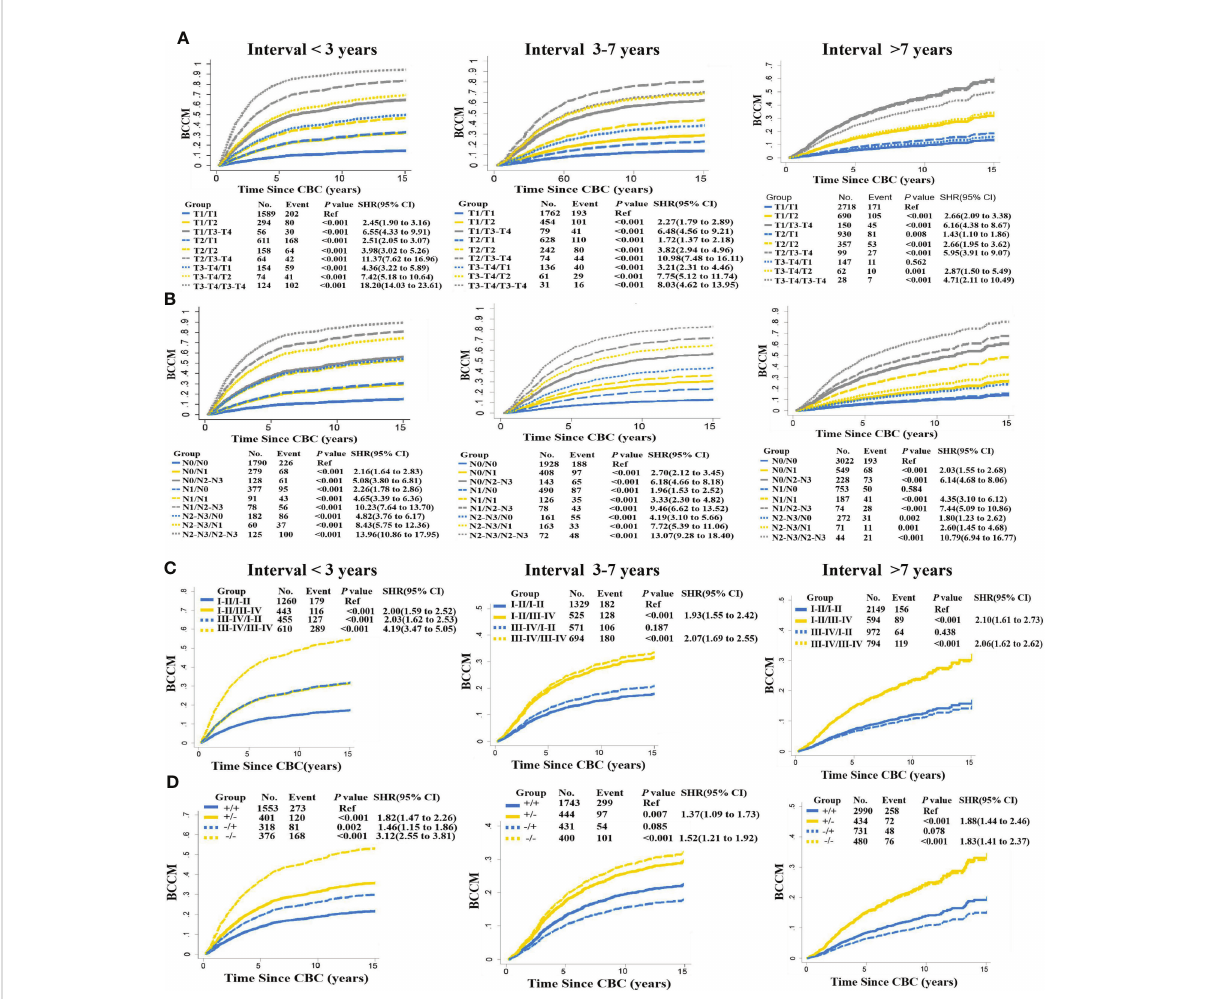
FIGURE 3 Interval time in strati fi ed BCCM of MBBC characteristics. Risk group strati fi cation within each prognostic factor with distant interval time (< 3, 3 – 7, > 7 years), including T stage (A) , N stage (B) , grade (C) , and ER status (D) . The same features of PBC are re fl ected with the same line type (solid or dashed line), and the same features of CBC are re fl ected with the same line color (blue, yellow, or